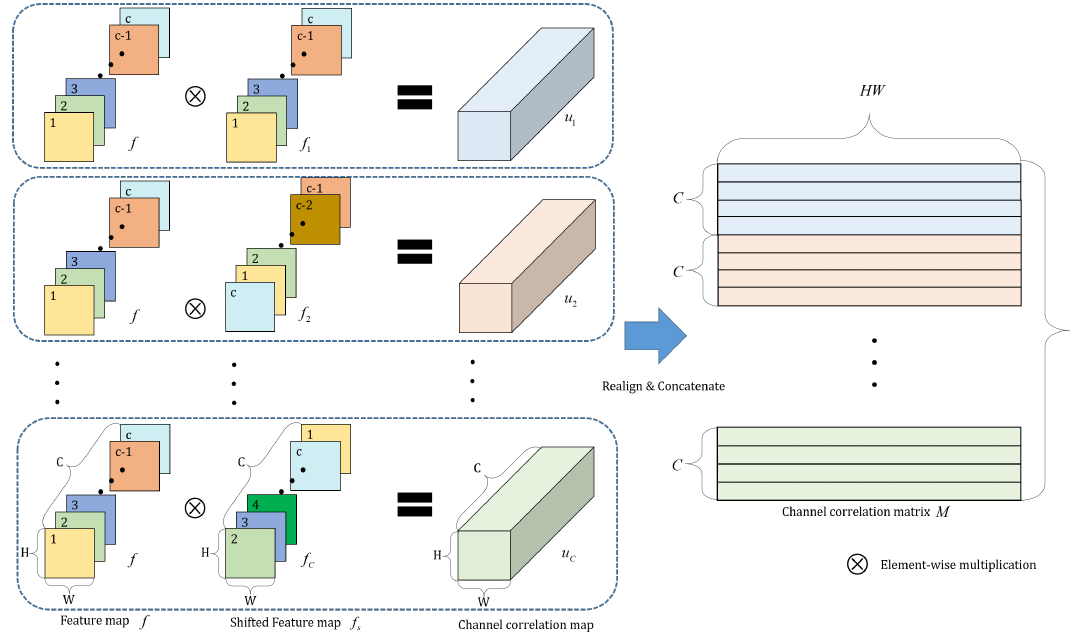
Figure 3. Illustration of the method to form the channel correlation matrix M . The feature map f is the normalized logit of network. The shifted feature map f s is obtained by shifting f along the channel axis. The channel correlation map u is obtained by multiplying the feature map f and the shifted feature map f s . All the channel correlation maps u s are concatenated along the channel axis to form a total channel correlation map u , which is converted to the channel correlation matrix M by rearranging it.